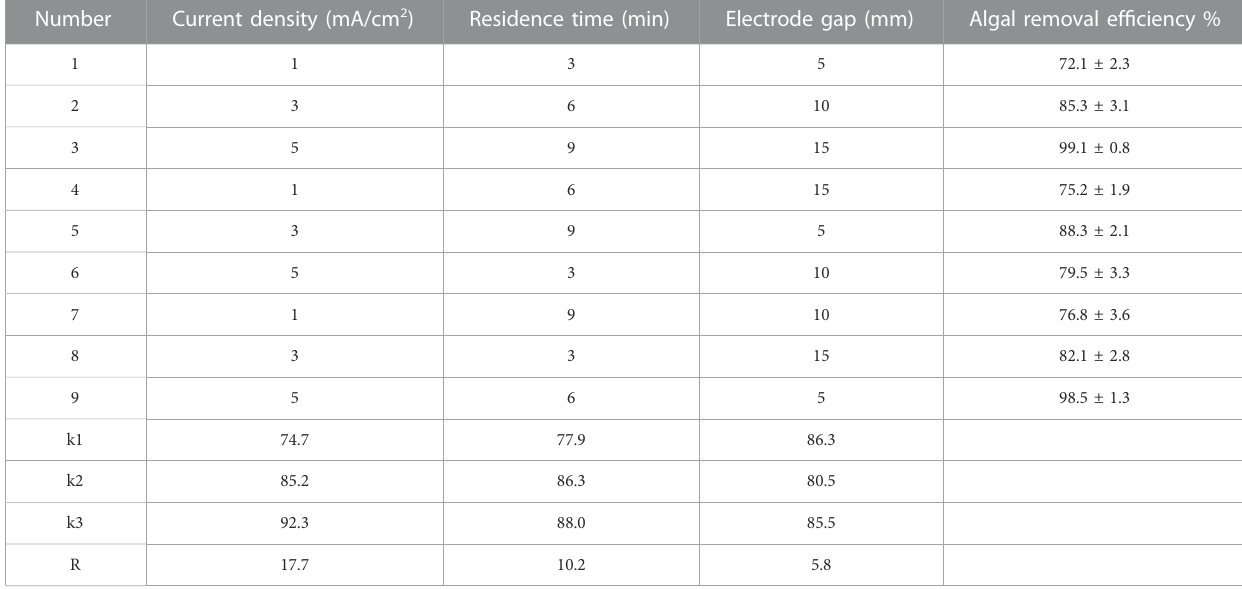
TABLE 3 Positive solutions of experimental